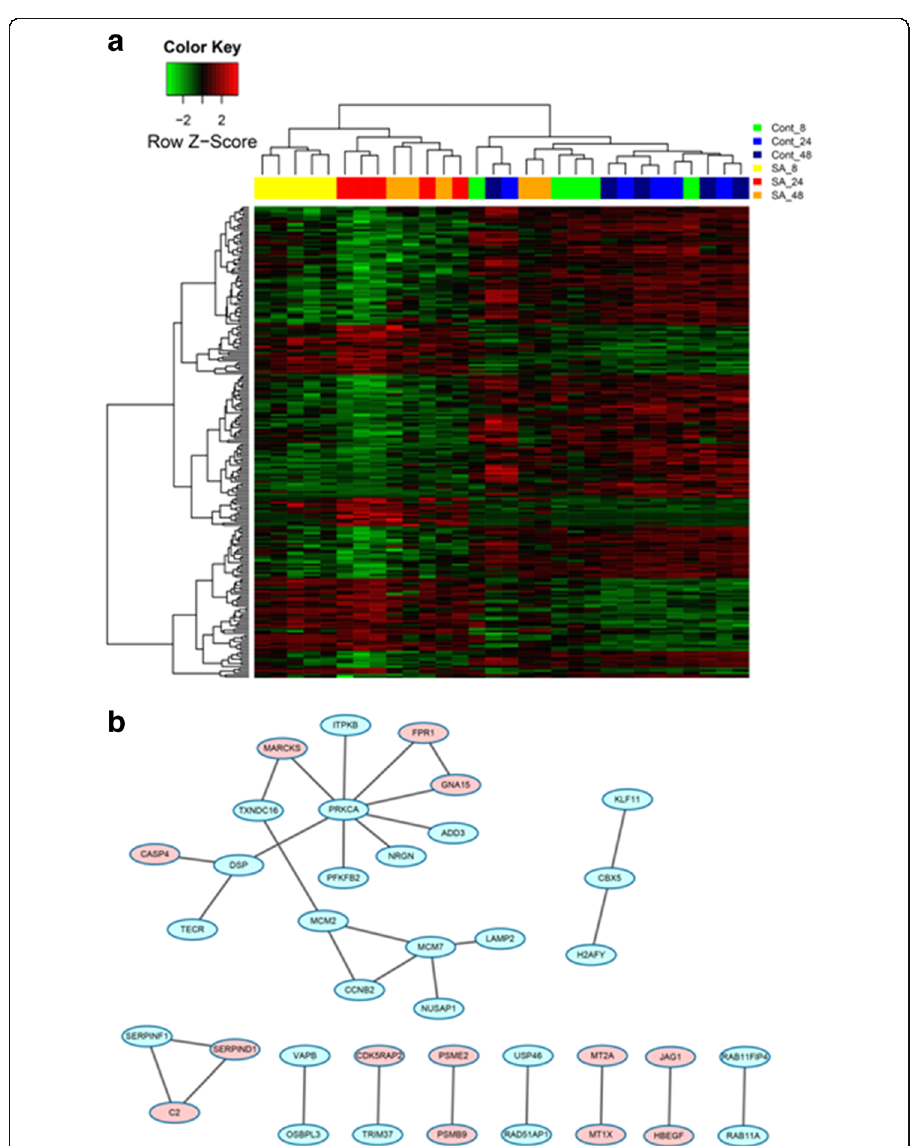
Fig. 4 Heat map of common DEGs in Comparison 2 ( a ) and corresponding biological network ( b ). a Heat map of hierarchical clustering for common DEGs in Comparison 2. “ Red ” : high expression, “ green ” : low expression. b Biological network constructed according to the direct connection among DEGs. “ Red ” : up-regulation, and “ green ” :